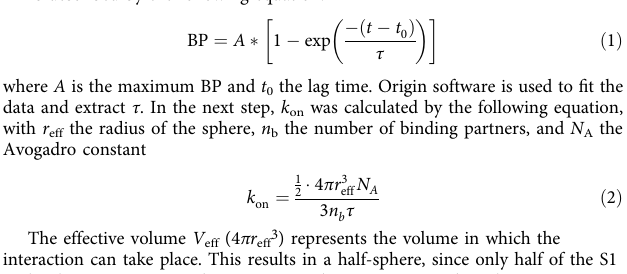
The effective volume V eff (4 π r eff 3 ) represents the volume in which the interaction can take place. This results in a half-sphere, since only half of the S1 molecules can interact with its corresponding receptor on the substrate.